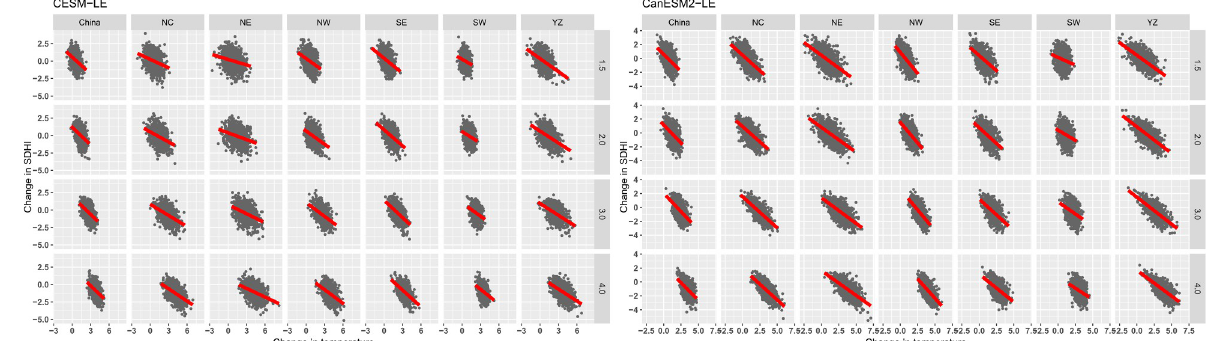
Fig 5. Scatter diagram of SDHI changes and temperature changes in China and its six subregions under different warming scenarios. The solid line represents the linear regression.